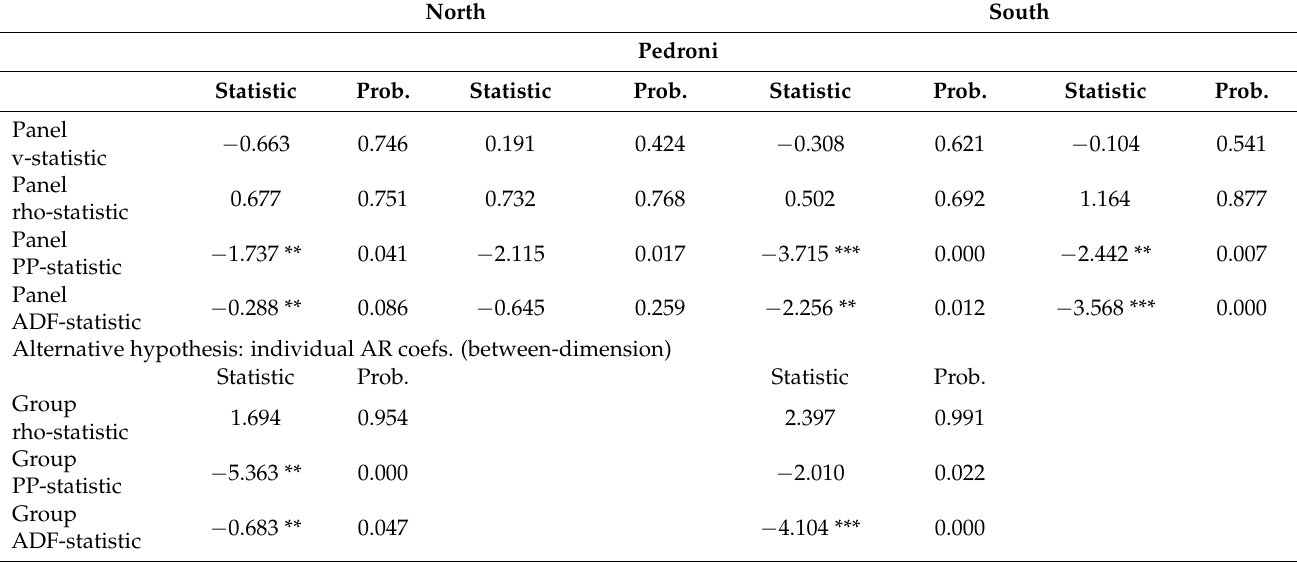
Table 4. Cointegration